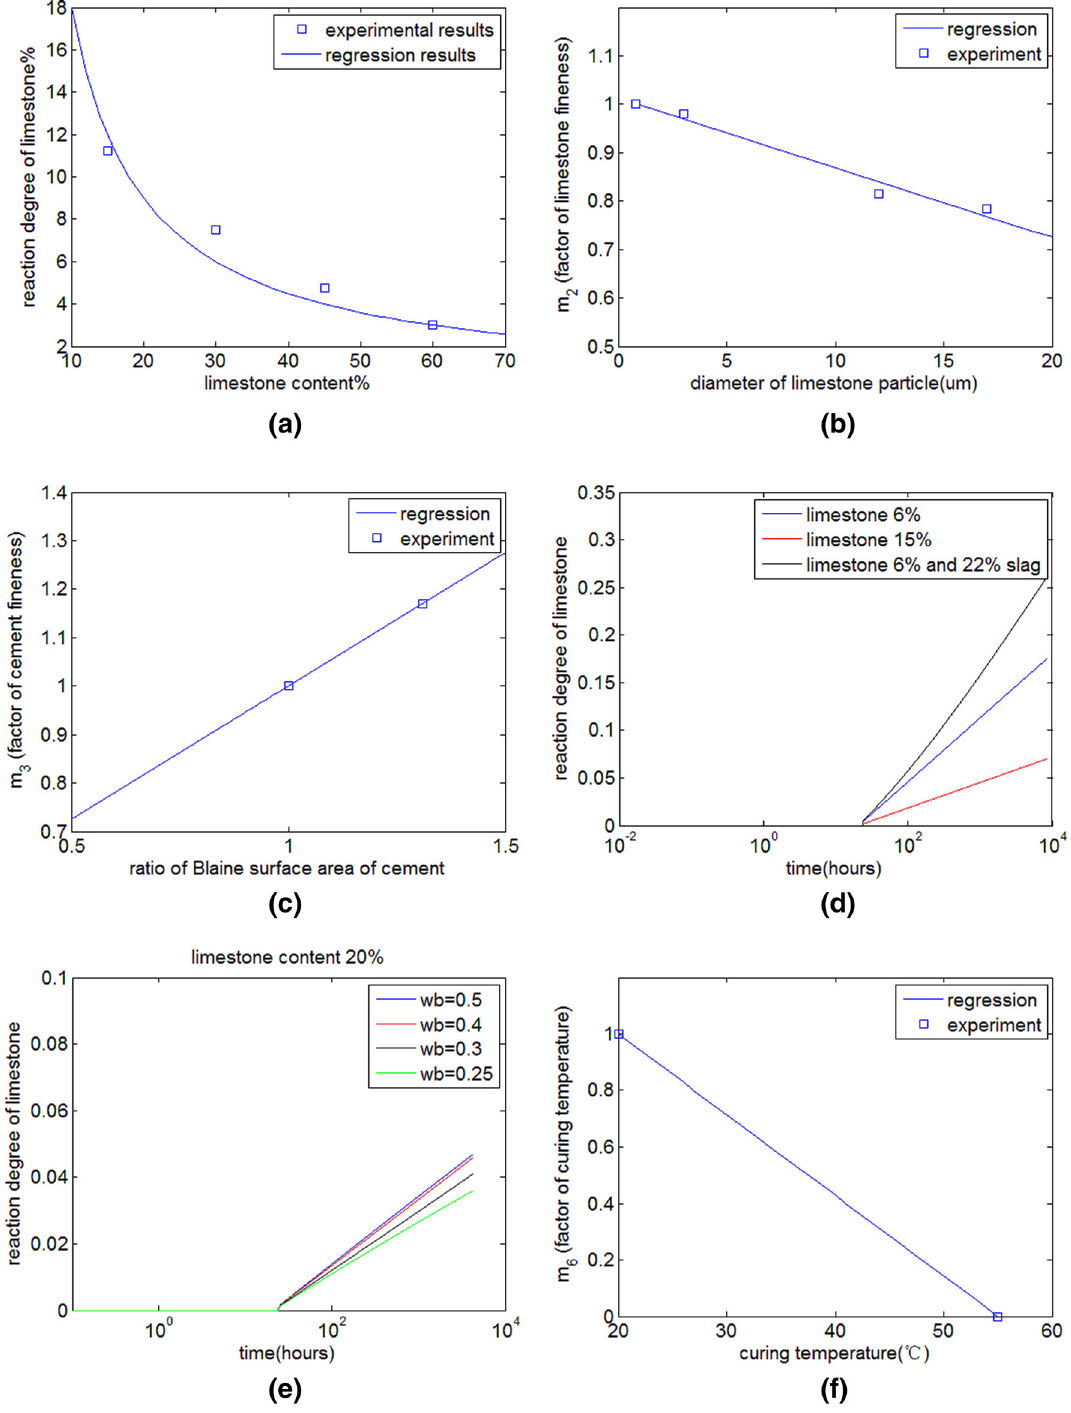
Fig. 2 Modification factors of limestone reaction. a limestone replacement ratios, b finenes of limestone, c fineness of cement, d slag additions: water to binder ratio 0.5, e water to binder ratios: 20% limestone, f curing